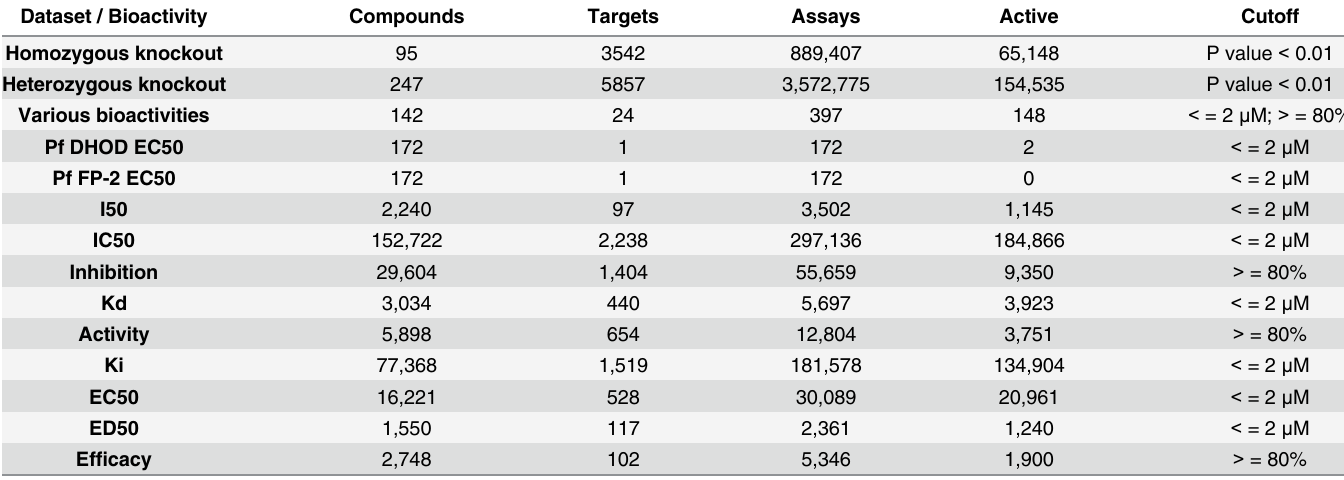
Table 1. Bioactivity types and activity cutoffs. The table lists the TDR Targets bioactivity types considered (as reported by paper authors or as imported by curators of the corresponding sources, the number of targets, compounds, and assays (bioactivity data points) in each case. The last two columns show the number of assays in which molecules were classified as active, and the corresponding cutoff value used in this classification. Pf = Plasmodium falciparum; DHOD = Dihydroorotate dehydrogenase; FP-2 = falcipain-2. Dataset /